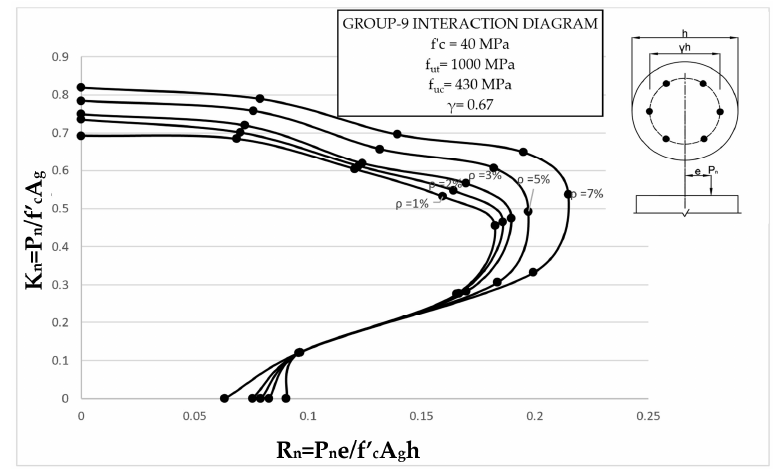
Figure 21. Group 9 interaction diagram. Materials 2020 , 13 , x FOR PEER REVIEW